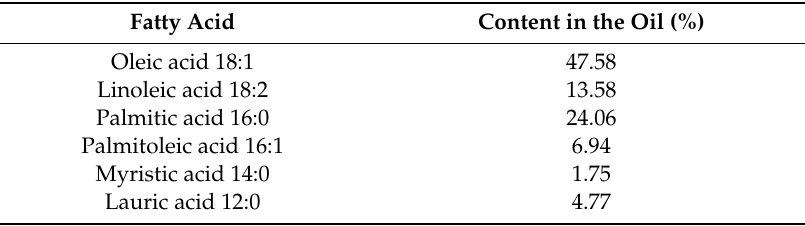
Table 1. Composition of Euterpe oleracea Mart oil fatty acids quantified using gas chromatography with a flame ionization detector.